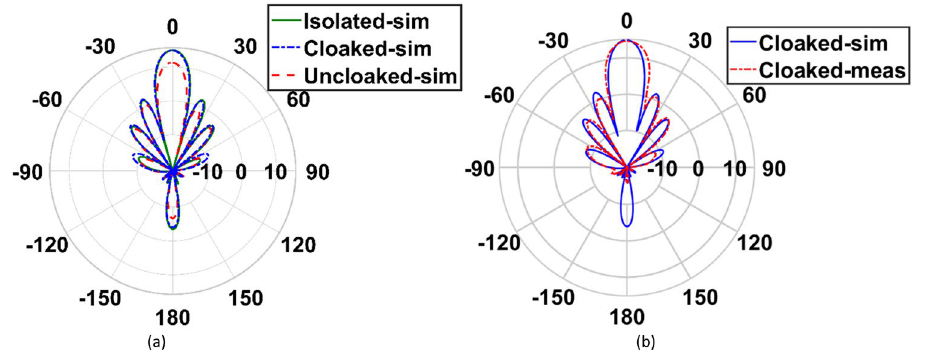
Figure 14. ( a ) Comparison between the gain pattern of array I in isolated, cloaked and uncloaked cases, ( b ) measured and simulated patterns of the cloaked